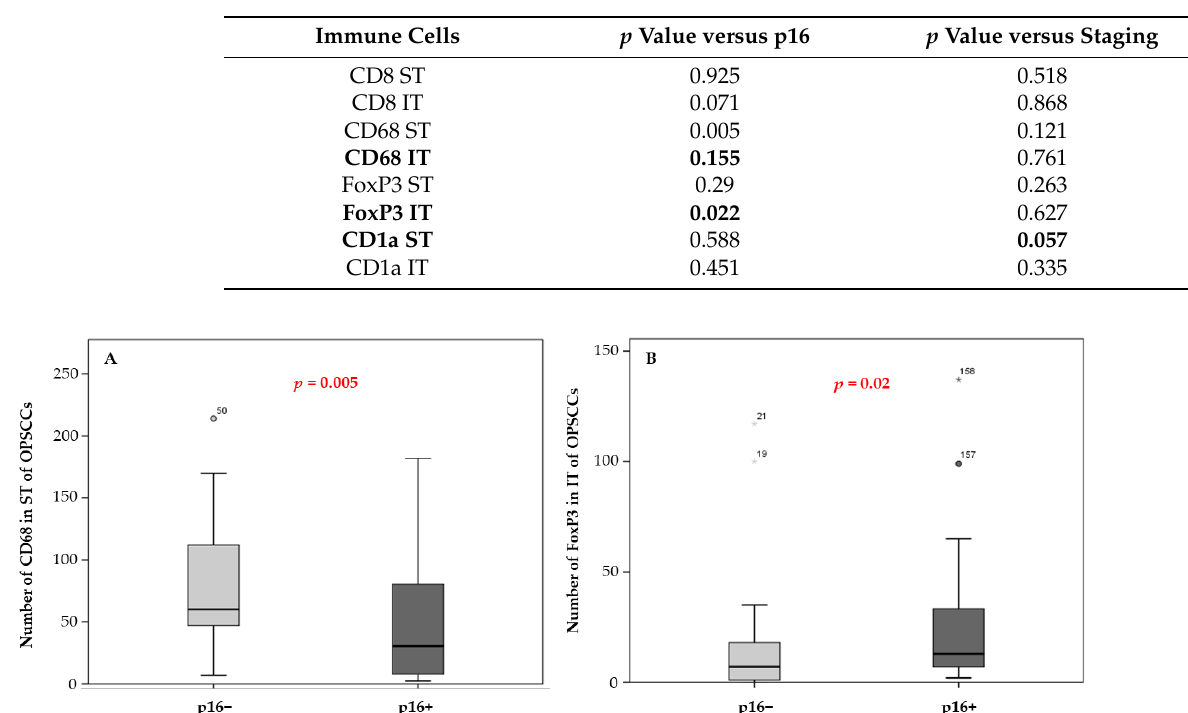
Table 4. Mann–Whitney test between immune cell density in ST and IT compartments and p16 status or staging. p values < 0.05 are highlighted in bold.